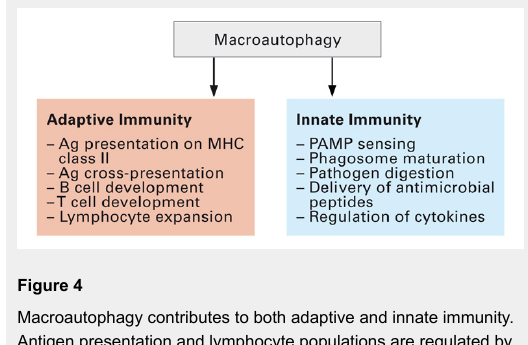
Macroautophagy contributes to both adaptive and innate immunity. Antigen presentation and lymphocyte populations are regulated by macroautophagy during adaptive immune responses. In addition, pathogen sensing and their degradation are also supported by this catabolic